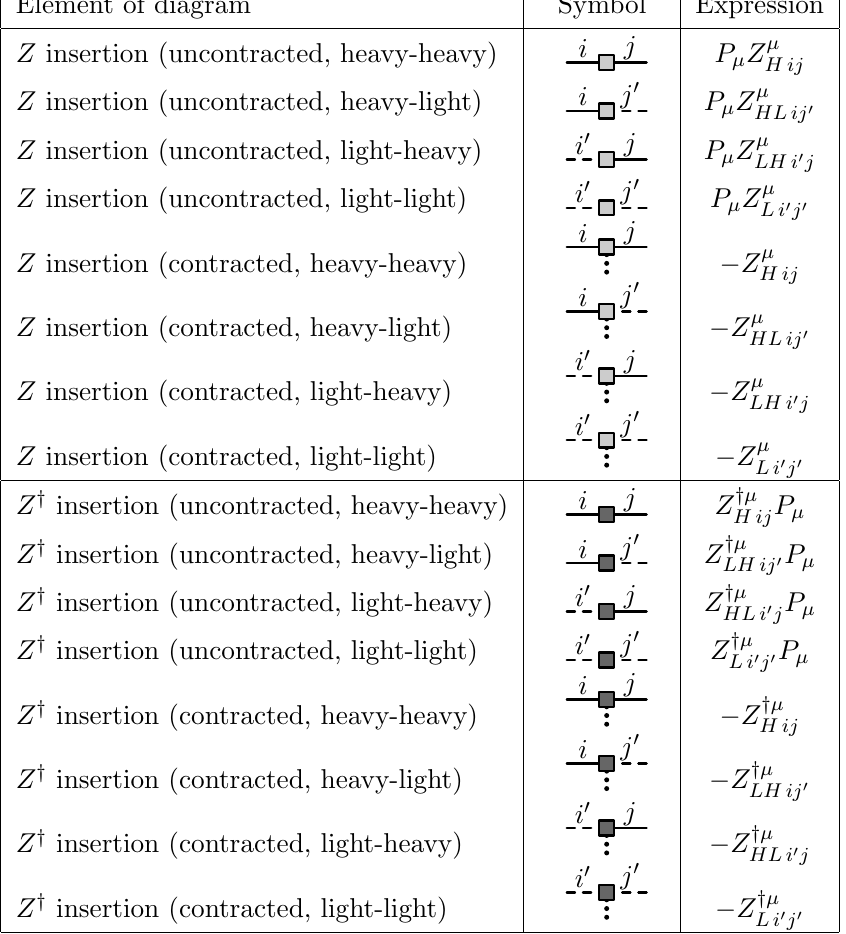
Table 3 . Additional building blocks of covariant diagrams in the presence of open covariant derivatives in the X matrix, as derived in section 3.3, up to one-open-covariant-derivative terms